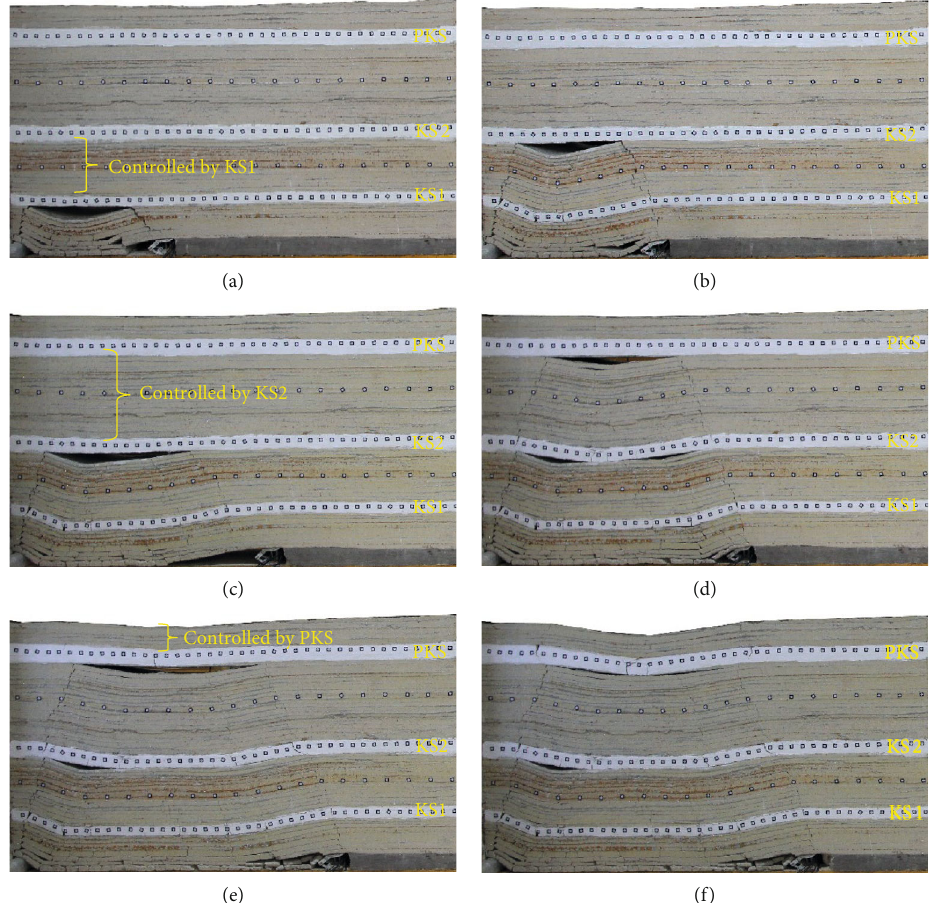
Figure 2: The control e ff ect of the key stratum: (a) before the breakage of KS1; (b) after the breakage of KS1; (c) before the breakage of KS2; (d) after the breakage of KS2; (e) before the breakage of PKS; (f) after the breakage of